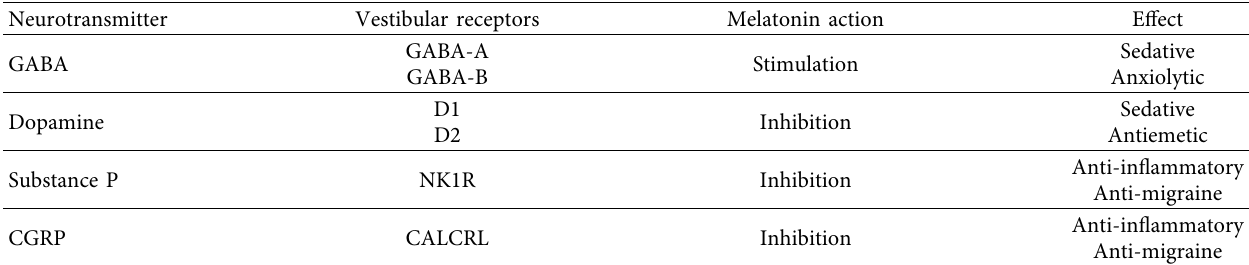
Table 1: Melatonin effects on